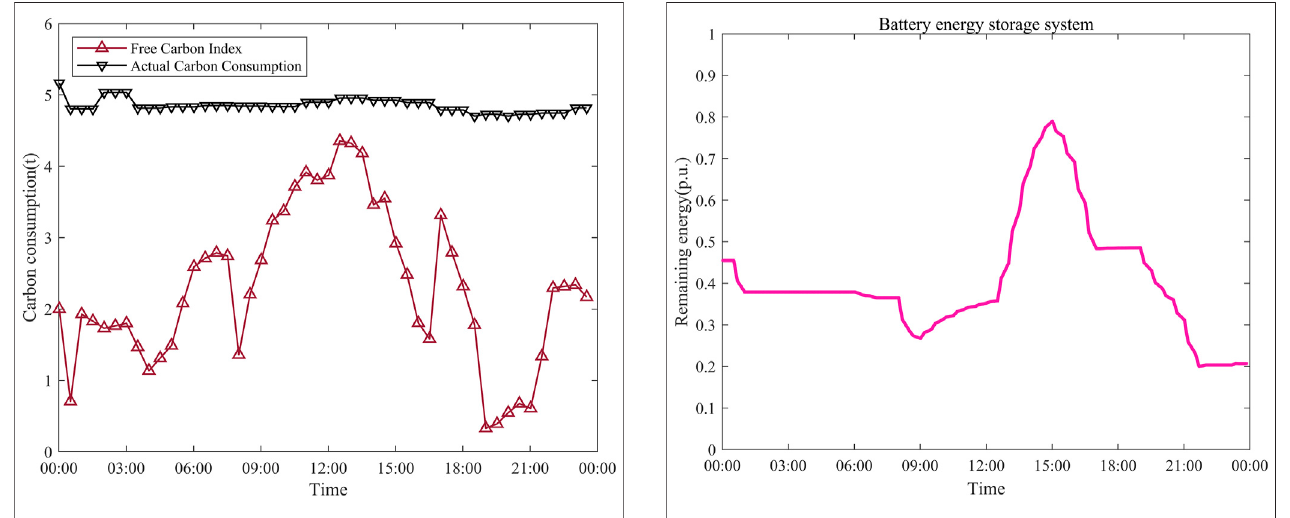
FIGURE 7 | The change of carbon index and consumption. FIGURE 8 | The change of power storage in